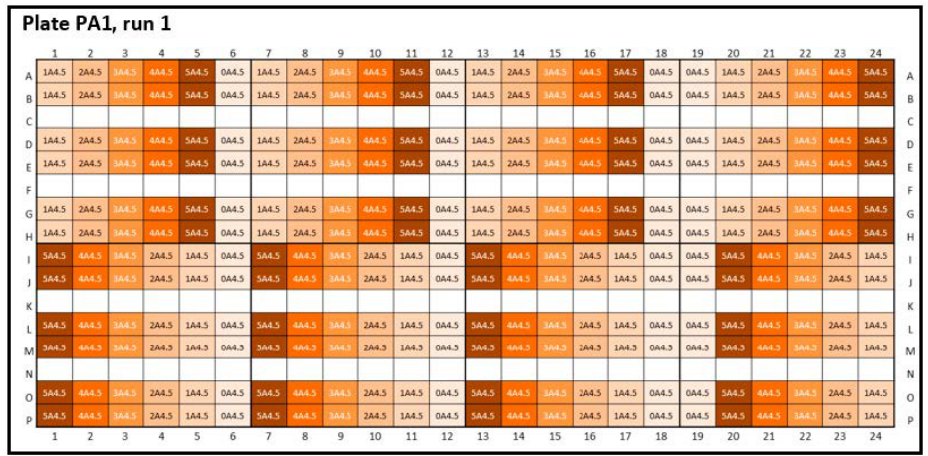
Figure A1. Experimental plate designs for intra-plate variability. Peptide-12 (P): two 384-well plates were analyzed: PA1 (positive k D ): A4.5 = acetate buffer, pH 4.5, and the concentration series were arranged horizontally; ascending concentrations are placed on the upper half of the plate and descending concentrations on the bottom half (1 = 2 mg/mL, 2 = 4 mg/mL, 3 = 6 mg/mL, 4 = 8 mg/mL, 5 = 10 mg/mL API, and 0 = placebo). The design of plate PP1 (negative k D ) for phosphate buffer, pH 6.0, was equal to plate PA1.